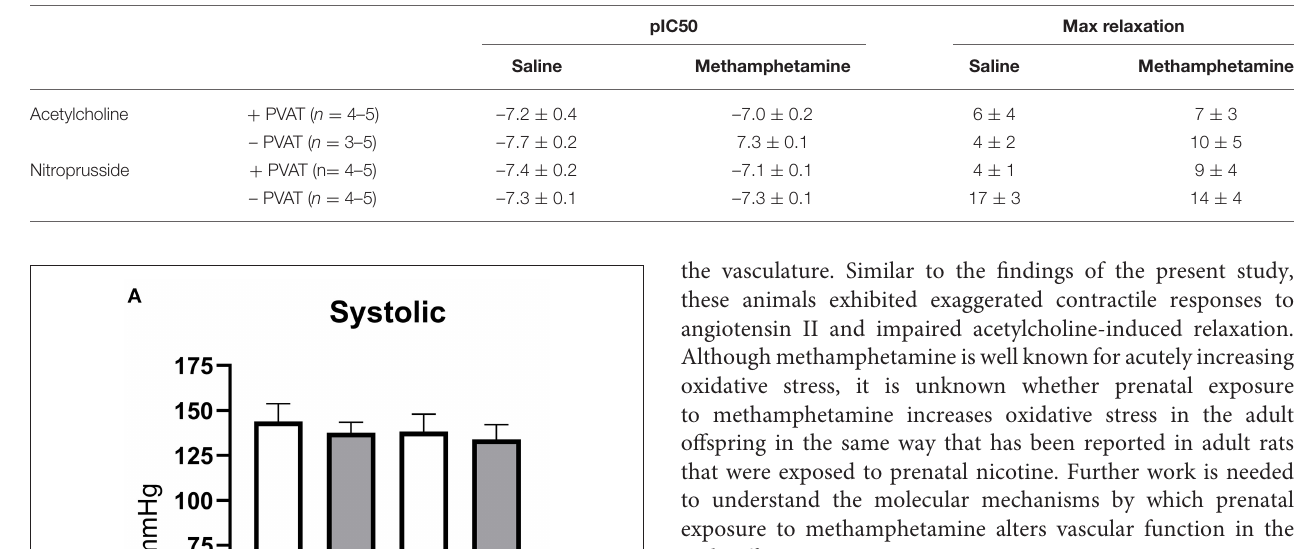
TABLE 5 | Acetylcholine- and nitroprusside-induced relaxation responses in third order mesenteric arteries isolated from adult male rats following prenatal exposure to saline or methamphetamine (5 mg/kg/day) throughout the gestational period.